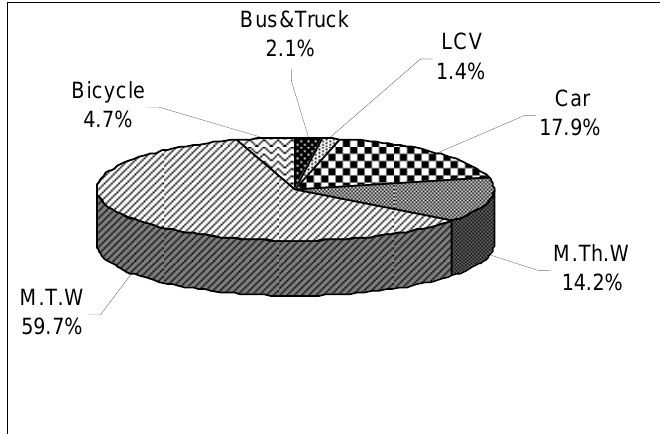
Figure 3. Traffic composition at the study road